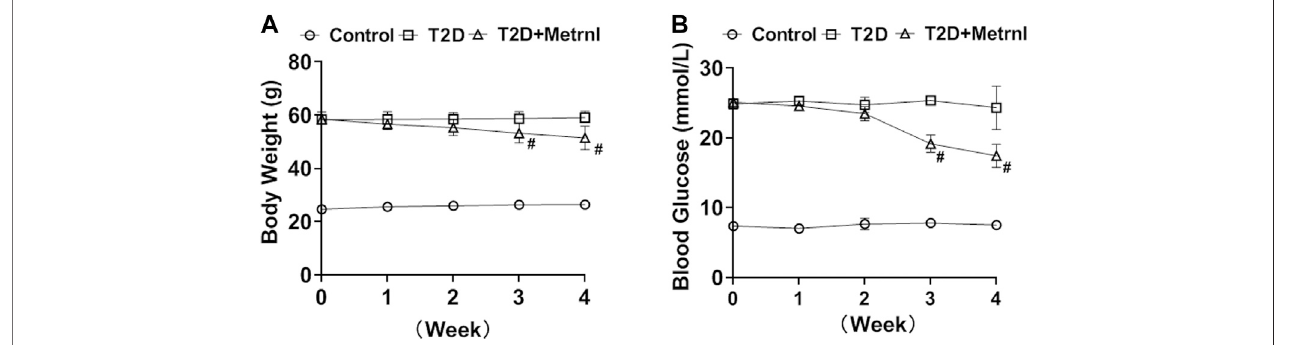
FIGURE 6 | The body weight and blood glucose in mice. (A) The body weight differences of mice between three groups. (B) The blood glucose differences between three groups. All data are expressed as mean ± SEM( n (cid:2) 8/group). # p < 0.05 for differences vs. T2D group. T2D: type 2 diabetes.